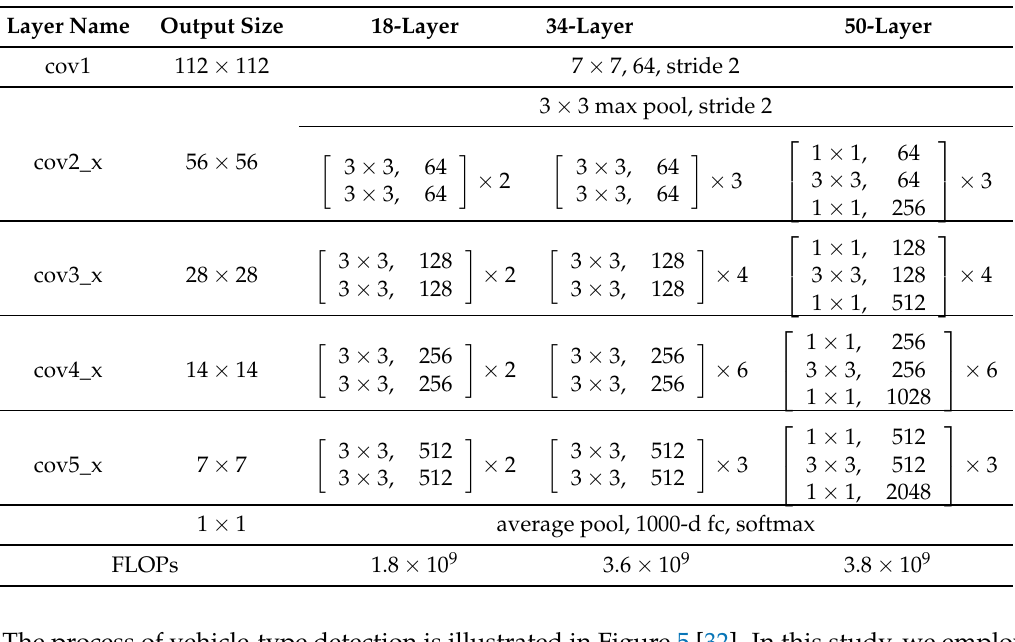
Table 1. Structure of ResNet.